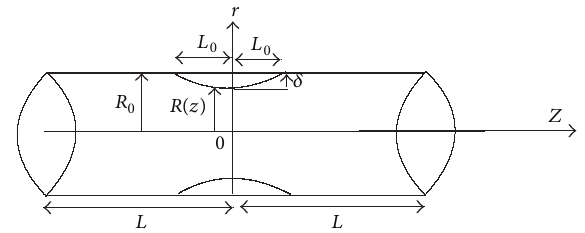
Figure 1: Geometry of the arterial segment with